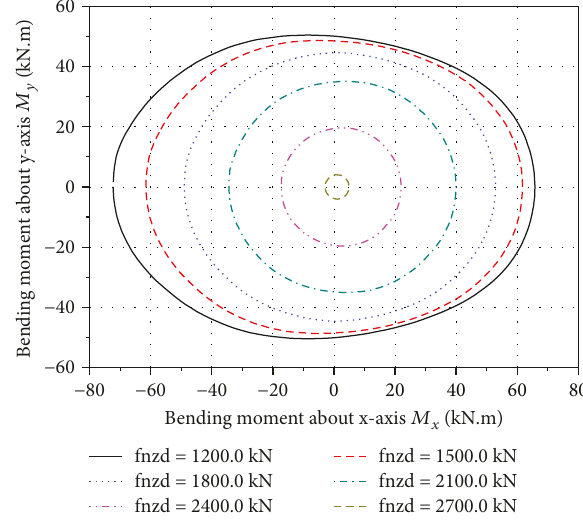
− M Figure 11: M x y interaction curves of the composite column with a T-shaped steel under di ff erent axial load